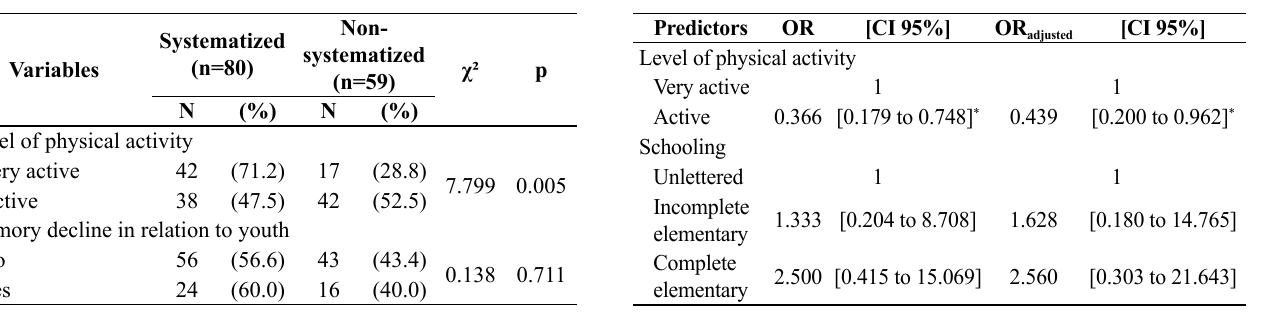
Table 3. Factors associated with the practice of systematized physical activity in the elderly.